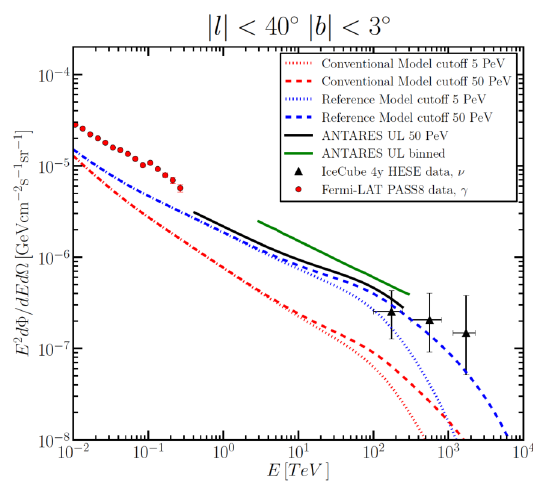
Figure 5. ANTARES upper limits on the three- fl avor neutrino fl ux corresponding to the inner Galactic Plane region contained < 40 ◦ and < 3 ◦ l b in | | | |